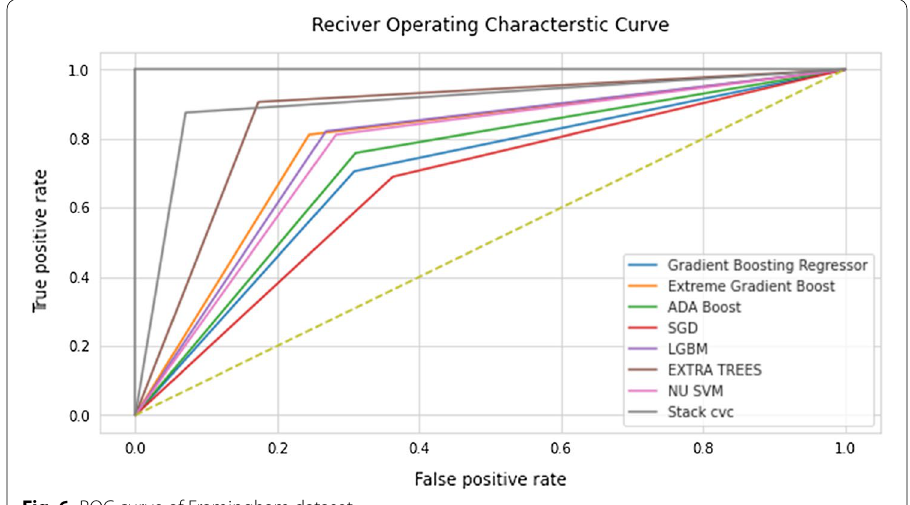
Fig. 6 ROC curve of Framingham dataset